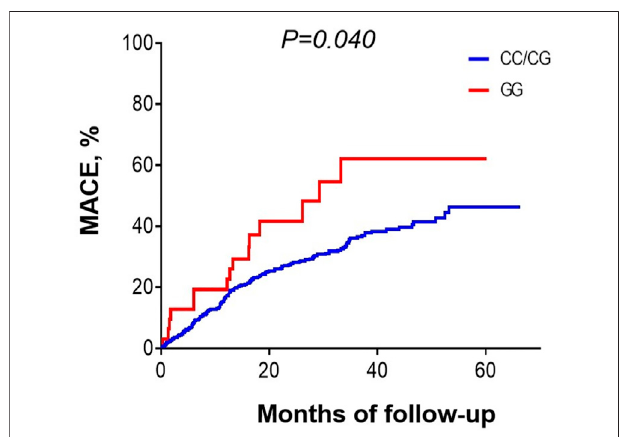
FIGURE 2 | Kaplan-Meier curves showing the prevalence of major adverse cardiovascular events in patients with different MIF genotypes during 25 months (12 – 60 months) follow-up